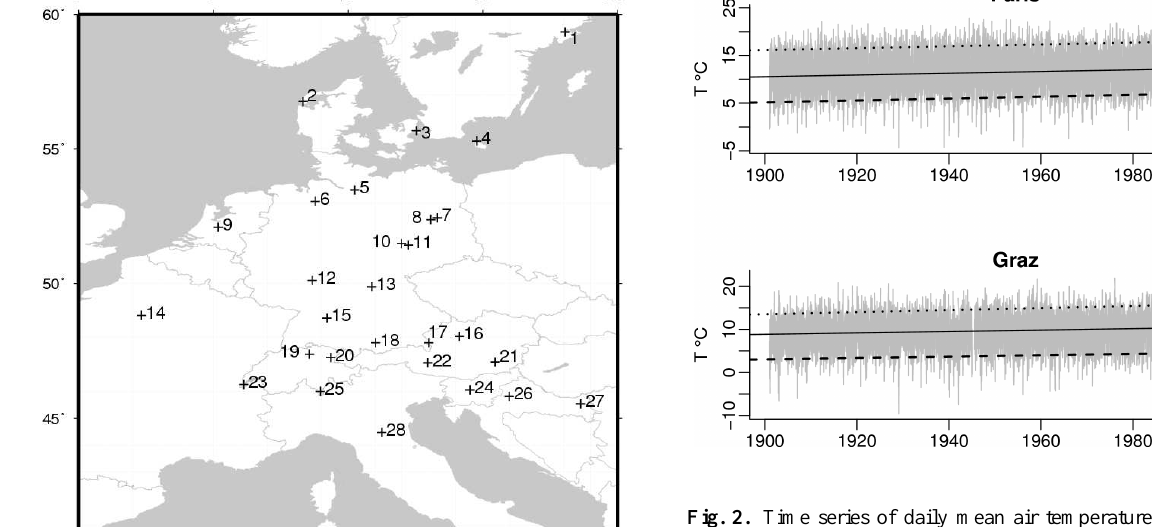
Fig. 2. Time series of daily mean air temperature and trends for quantiles 0.05 (dashed line), 0.5 (solid line) and 0.95 (dotted